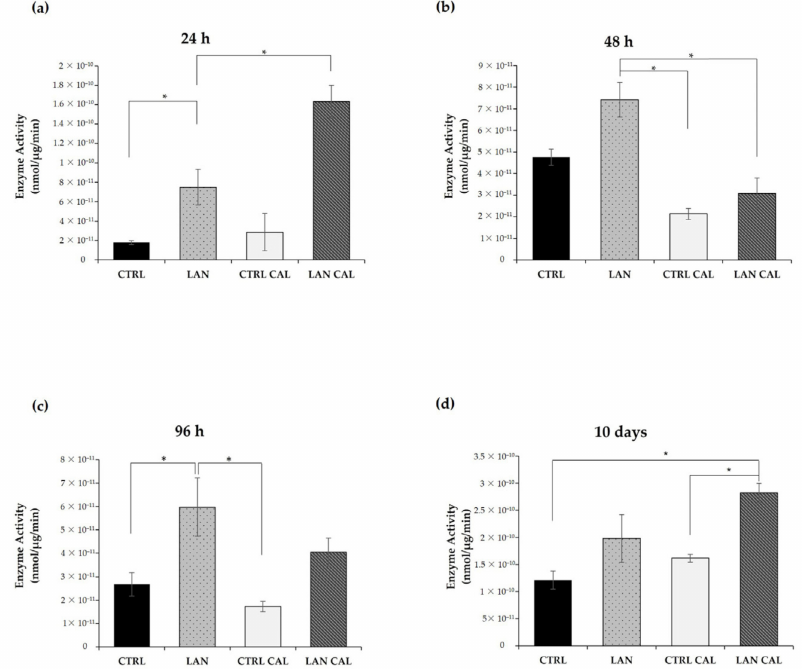
Figure 7. The alkaline phosphatase enzyme activity assay in Ea.hy926 cells upon lanthionine treat- ment in the presence of pro-calcifying medium conditions. The alkaline phosphatase enzyme assay after 1 µ M of lanthionine and 1 µ M of lanthionine with 2.8 mM of CaCl 2 and 3 mM of NaH 2 PO 4 treatment in 24 h ( a ), 48 h ( b ), 96 h ( c ) and 10 days ( d ). To understand the effects of lanthionine under pro-calcifying conditions, a control with 2.8 mM of CaCl 2 and 3 mM of NaH 2 PO 4 was tested. Enzyme activity corresponds to the release of p-nitrophenol from disodium p-nitrophenyl phosphate measured at 405 nm. One unit of enzyme is defined as the amount of enzyme that hydrolyzes 1 nmol of p-nitrophenyl phosphate x min − 1 . Specific activity is expressed as nmol × min − 1 × µ g and is corrected for protein concentration of the cell lysates. The columns represent the mean and error bars indicating the SD from three independent experiments; p -value versus untreated control = * p < 0.05, (according to Anova-test). CTRL, untreated control; LAN, lanthionine; CTRL CAL, with 2.8 mM of CaCl 2 and 3 mM of NaH 2 PO 4 ; LAN CAL, lanthionine with 2.8 mM of CaCl 2 and 3 mM of NaH 2 PO 4